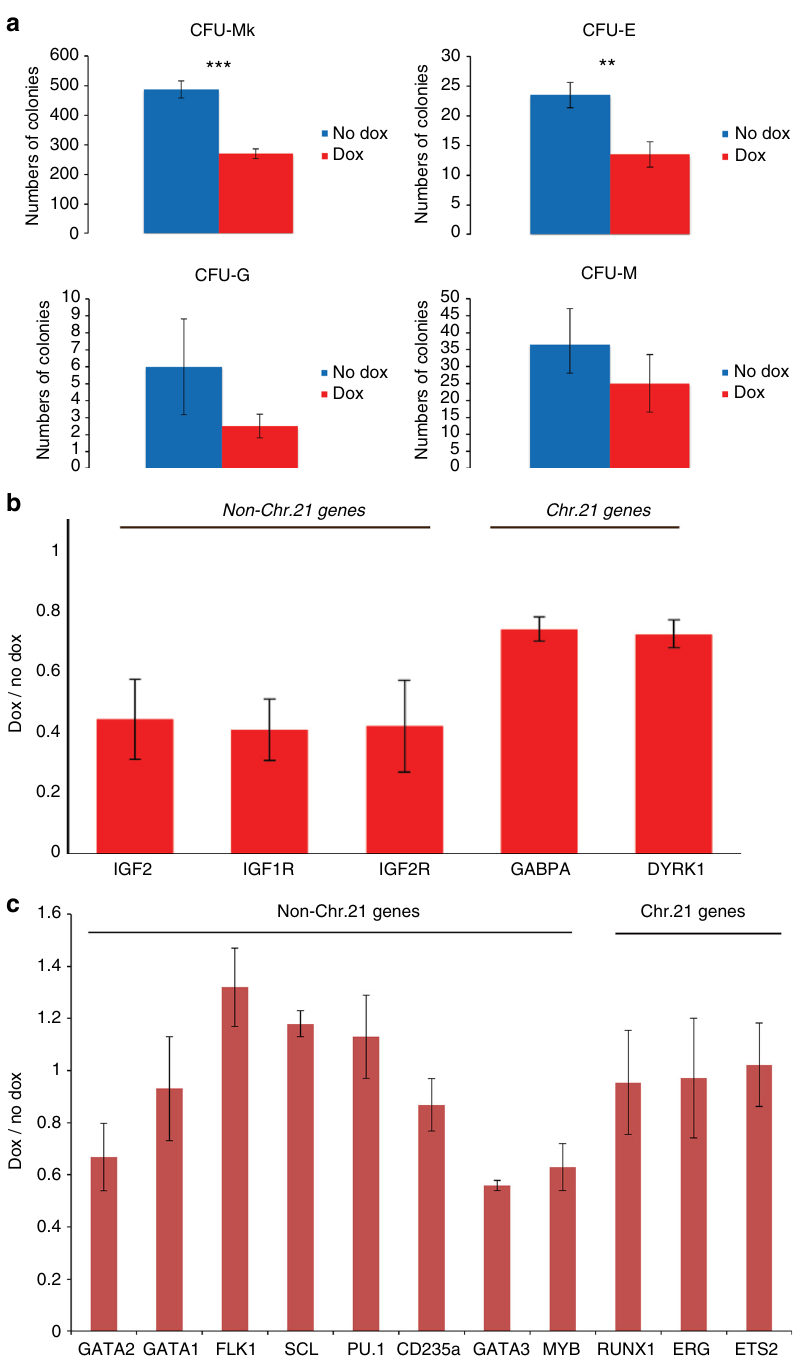
Fig. 5 Effects of trisomy silencing on day 14 puri fi ed CD43 + hematopoietic progenitors. a Colony-forming potential from equal numbers of puri fi ed day 14 differentiated CD43 + hematopoietic progenitor cells for (i) megakaryocytes, (ii) erythrocytes, (iii) granulocytes, and (iv) monocytes. b , c Gene expression analysis on b three IGF signaling-related genes and two chromosome 21 genes in puri fi ed day 14 CD43 + hematopoietic progenitors, and on c a panel of hematopoietic regulators, which are dynamically changing in different hematopoietic subpopulations. Expression levels were normalized to GAPDH and represented as the ratio of treated cells to untreated cells. Error bars represent s.e.m. from three independent experiments and P values were calculated by Student t test; * P < 0.05, ** P < 0.01, *** P < even for known hematopoietic regulators encoded on chromo- examine gene expression changes as a function of silencing the some 21, have alluded identi fi cation 11,20 . Since there is some third chromosome 21. The heterogeneous nature of hemato- poietic cell populations (even as de fi ned by speci fi c markers) and expression variability (or noise) inherent in different stem cell the rapidly changing levels of hematopoietic regulators during clones, we tested whether inducible chromosome silencing might hematopoiesis likely contribute to observations in multiple stu- be able to discern consistent changes, focusing on a small panel of dies that consistent changes in gene expression due to trisomy 21, genes of interest, as previously examined by Maclean et al. 20 . This